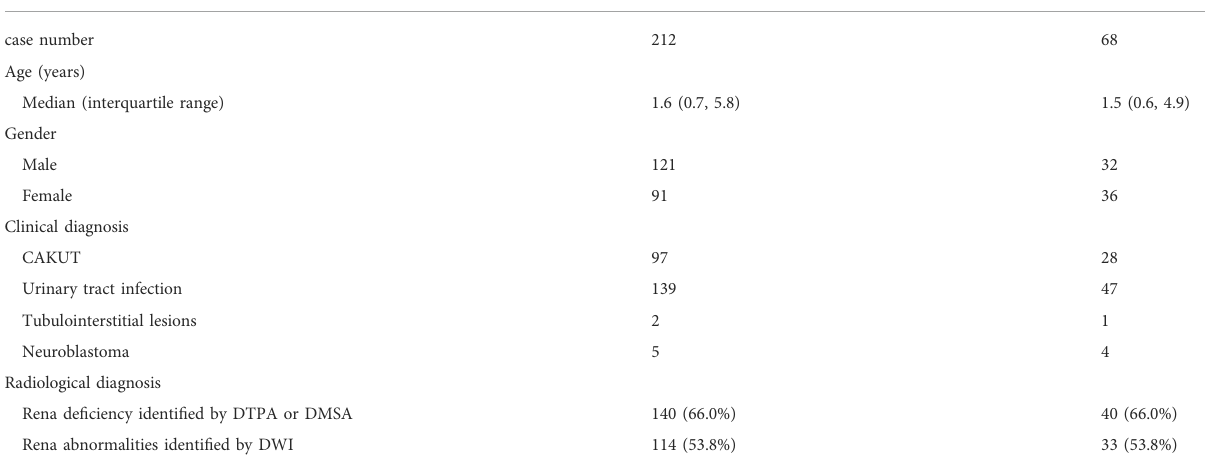
TABLE 1 Clinical characteristics of the